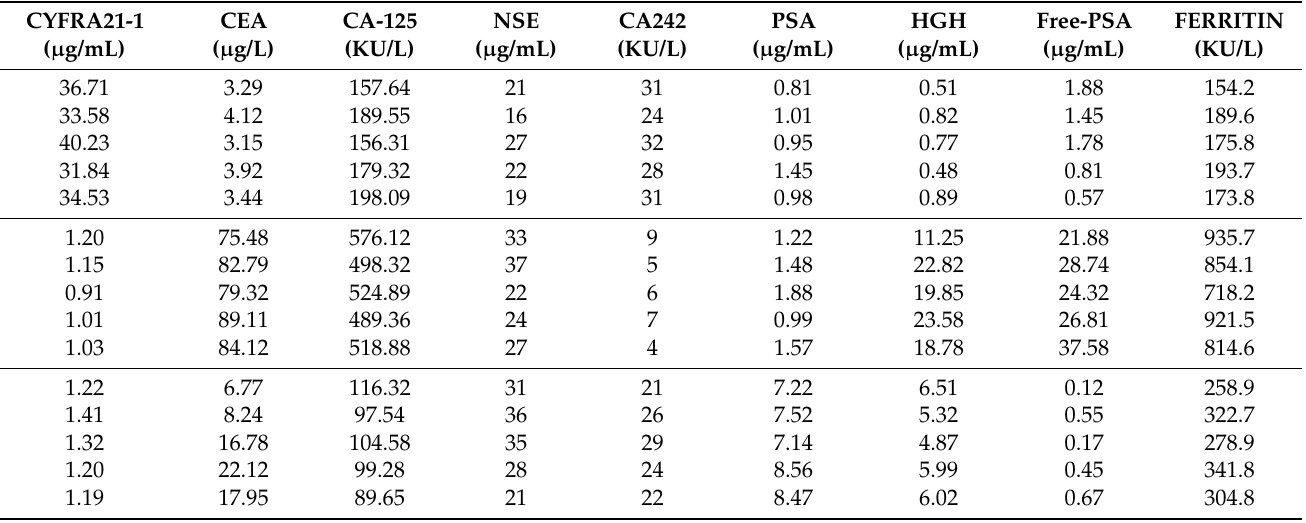
Table 5. Mean data of NSCLC diagnosis and decision parameters for each of the three randomly sampled patient groups at five